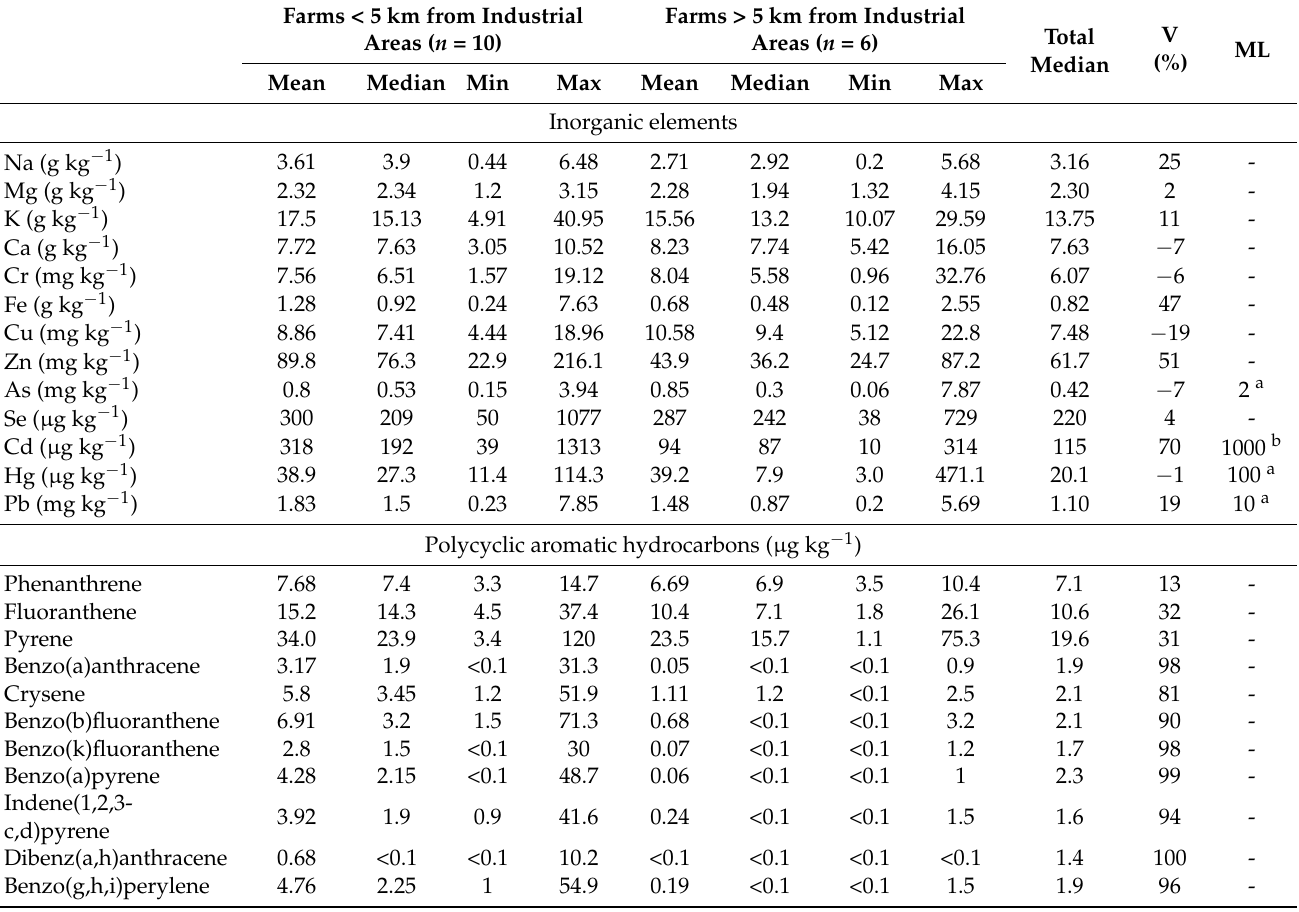
Table 3. Comparison of potentially toxic metals and polycyclic aromatic hydrocarbons in feed from farms <5 or >5 km from industrial